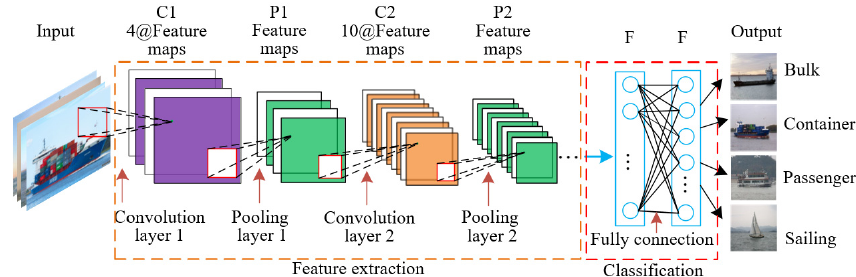
Figure 1. Typical convolutional neural network (CNN) structure.